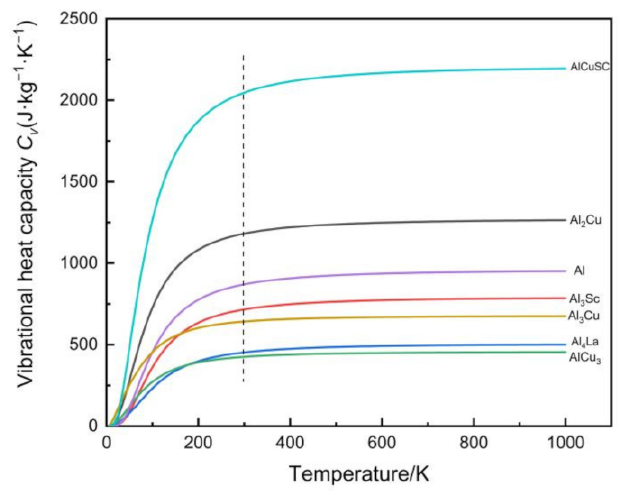
Figure 13. Vibrational heat capacity of different phases at 0–1000